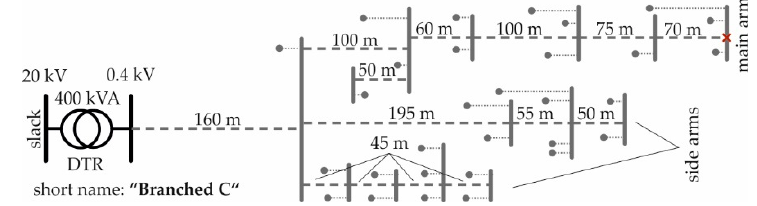
Figure 1. Theoretical LV test-feeders: ( a ) long overhead line feeder (“Long OL”); ( b ) short overhead line (“Short OL”); ( c ) long cable (“Long C”); ( d ) short cable (“Short C”).